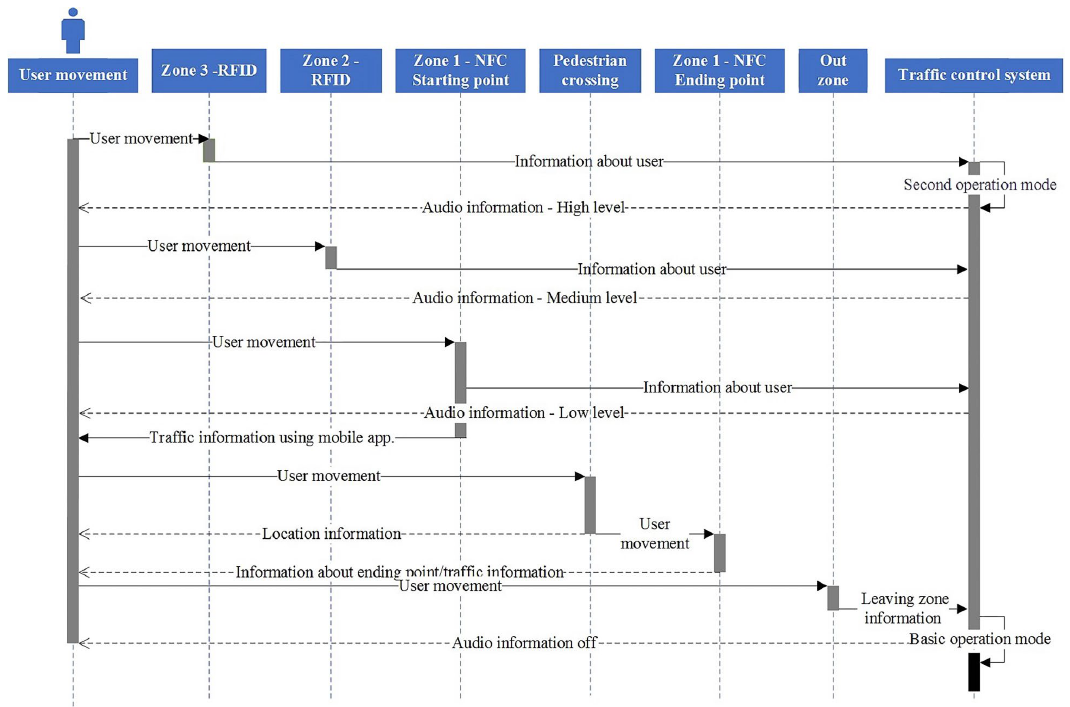
Fig. 4. Zones of identification and navigation of